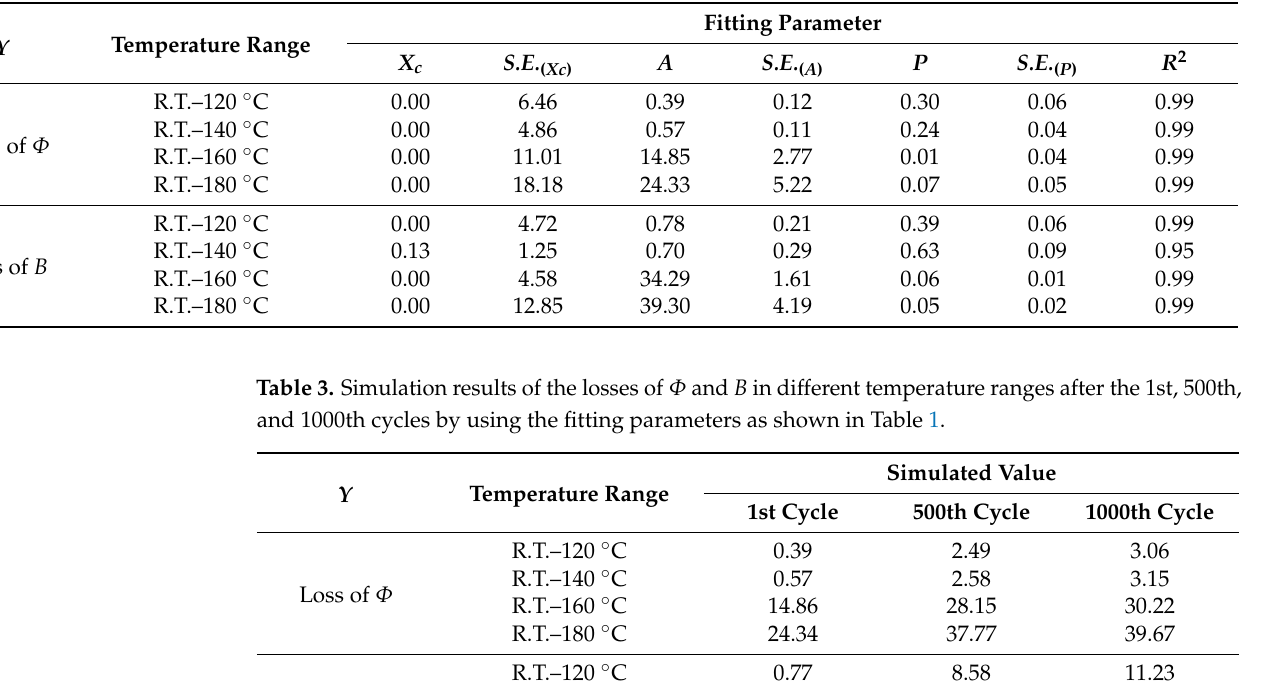
Table 2. Values of fitting parameters and their standard errors ( S.E. ) in the different temperature ranges. The fitting formula is given by Y = A × ( X − X c ) P .